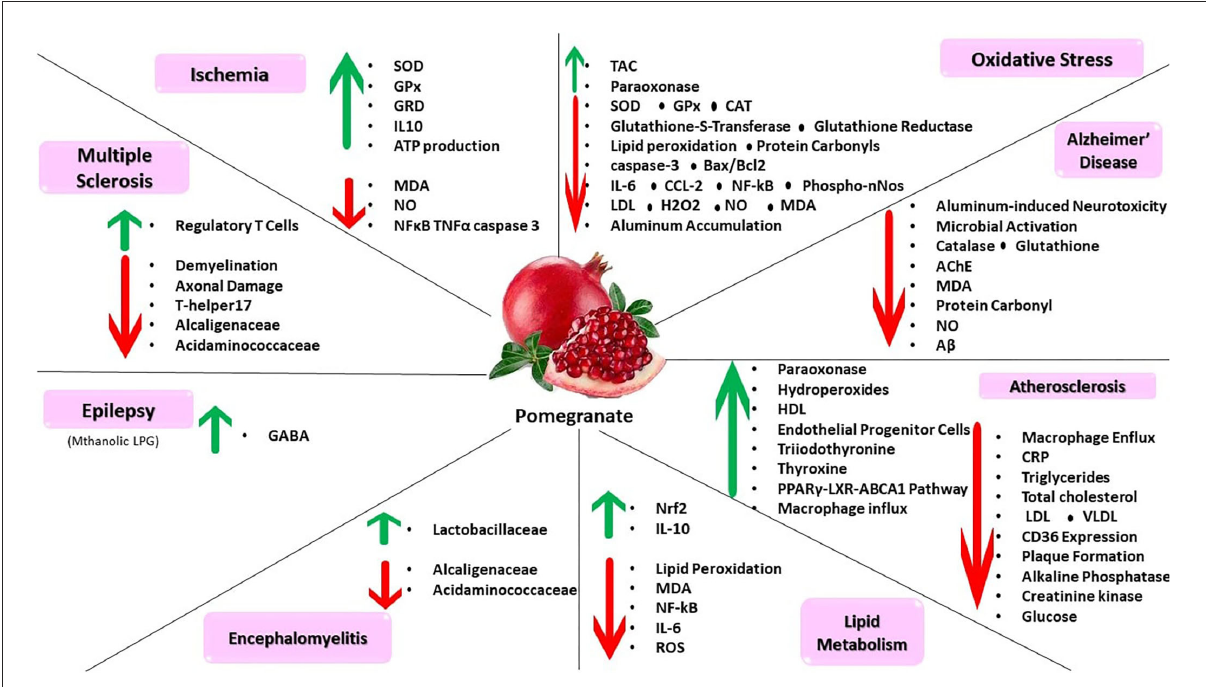
FIGURE2 Pomegranate can inhibit oxidative stress, atherosclerosis, lipid metabolism, and encephalitis. This compound has protective agents for age-related neurological disorders such as Alzheimer’s disease, epilepsy, multiple sclerosis, and ischemia.